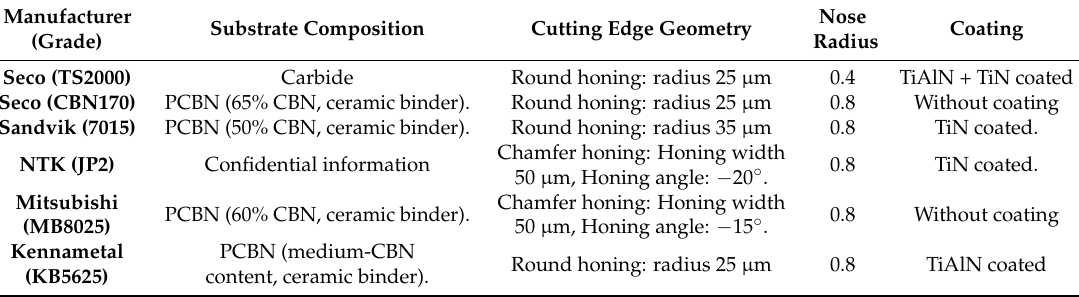
Table 2. Tool characteristics.